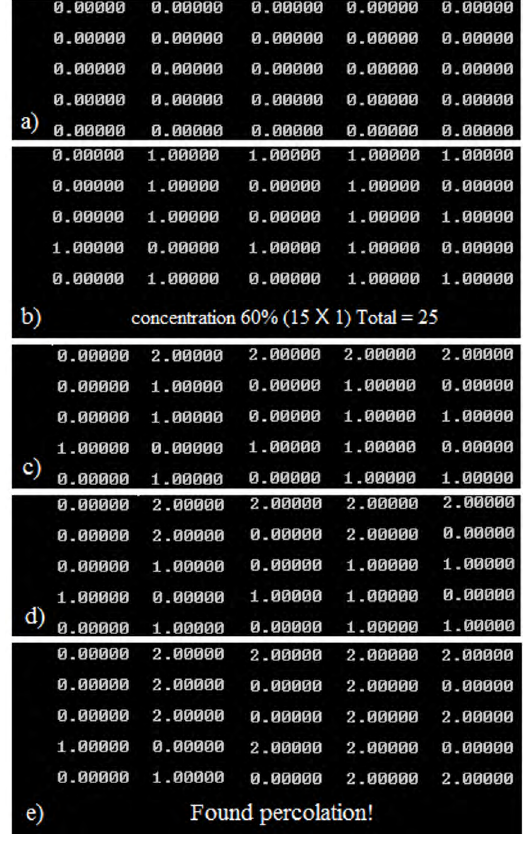
Figure 3. Matrices of verifier of Simulator of elements 5X5 with the concentration of 60% conductive